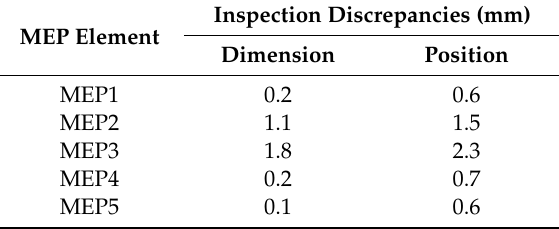
Table 4. Inspection discrepancies between the developed technique and ground truths for the checklist items for MEP